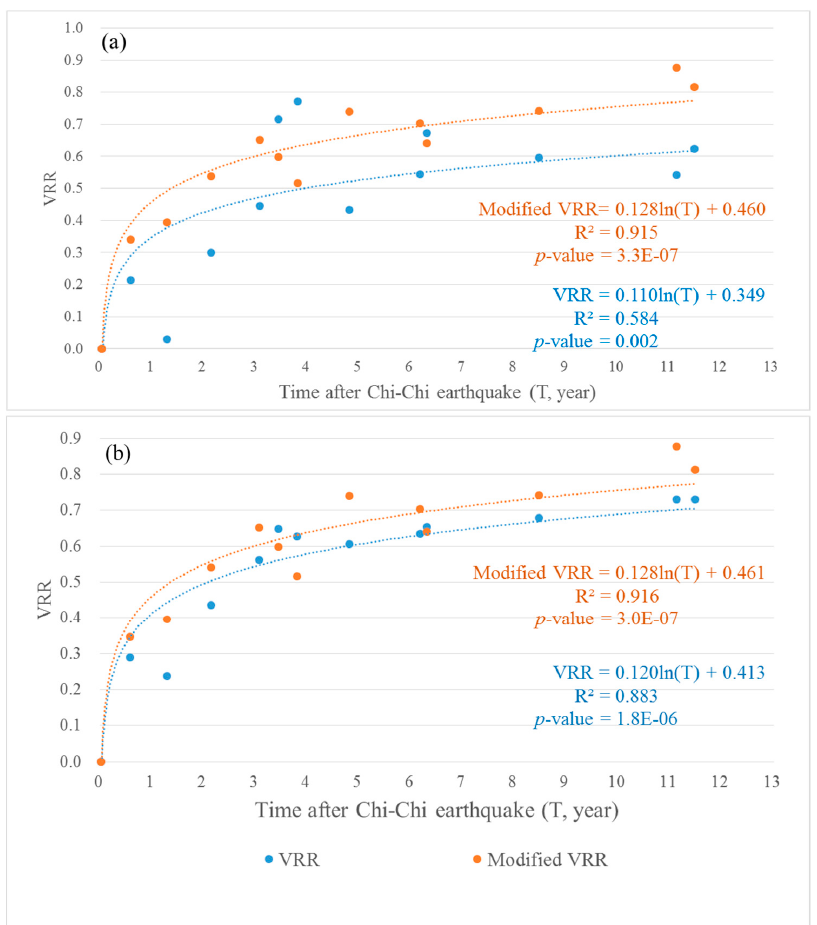
Figure 8. VRR and modified VRR for ( a ) total area and ( b ) landslide area.